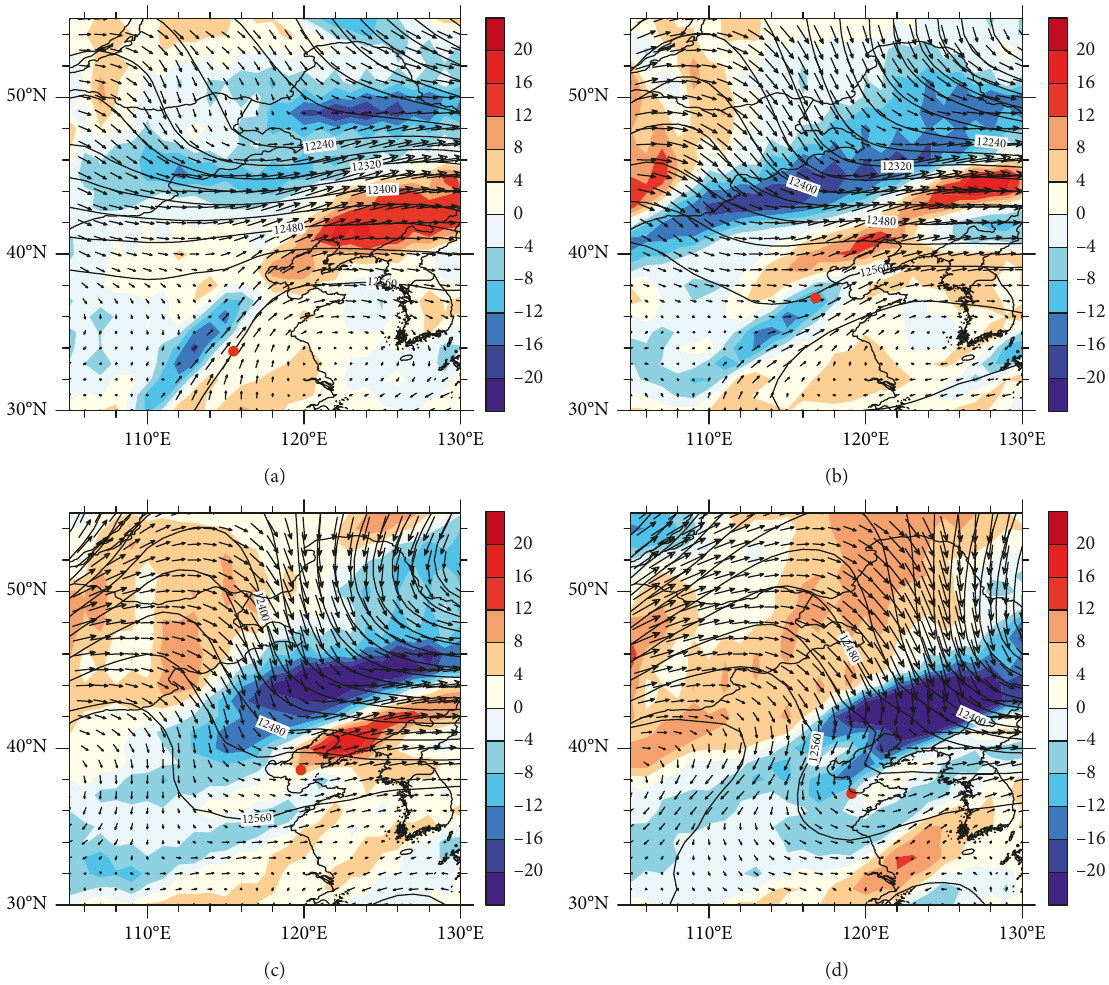
Figure 5: 200hPa circulation patterns: (a) 0000 UTC 14 August; (b) 1200 UTC 14 August; (c) 0000 UTC 15 August; (d) 1200 UTC 15 August. The contours represent the GPH (gpm), the vectors represent winds at 200hPa, the shading represents the divergence at 200hPa ( × 10 − 5 · s − 1 ), and the red dots represent the location of